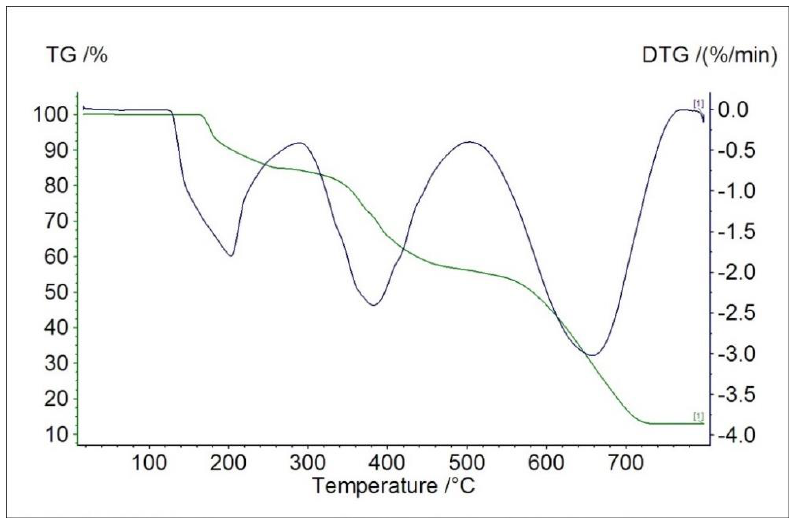
Figure 6. TG (green) and DTG (blue) curves showing Cu(F)Cl 2 compound decomposition pattern in air.